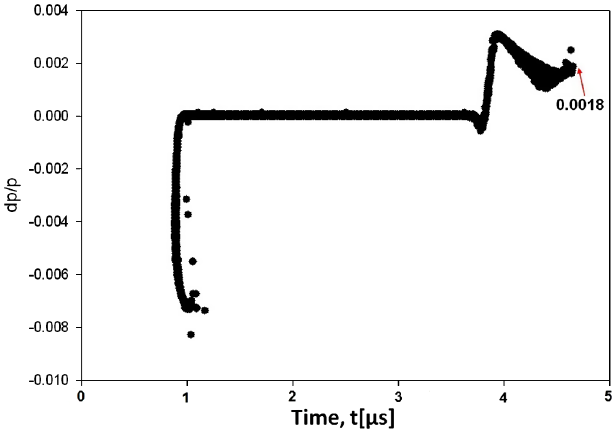
FIG. 27. Phase space distribution of particles at the end of the post-acceleration column.